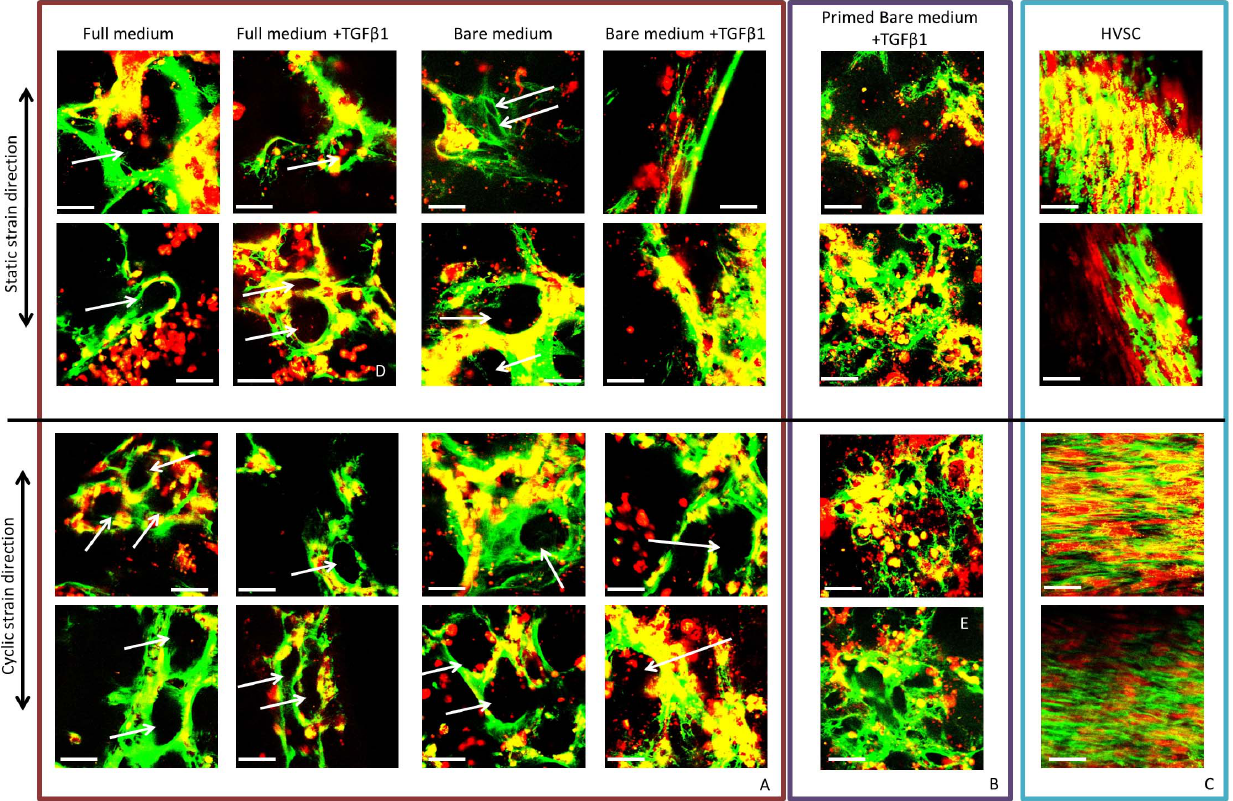
Figure 4. Confocal images of details (duplo) of ECFC- and HVSC-seeded constructs. Constructs were cultured for 19 days in all medium groups and under static or cyclic strain. Cells are shown in red, collagen in green. (A) ECFCs formed cell colonies and produced tubular collagen structures (indicated by white arrows) independent of medium type or strain, except when cultured in bare medium + TGF b 1 under static strain, when a slightly more alinged matrix was observed. (B) Primed ECFCs distributed more homogenously throughout the tissue and deposite collagen more homogenously throughout the tissue. (C) HVSCs showed distinct collagen alignment and strain responsiveness: collagen aligned parallel to the uniaxial strain direction in case of static straining and orthogonal to the strain direction in the cyclically loaded, biaxially constrained tissues. Scale bar indicates 50 m m. The difference in tubular structure for ECFCs and more homogeneous collagen distribution for primed ECFCs is shown in Movies for image (D) and (E).